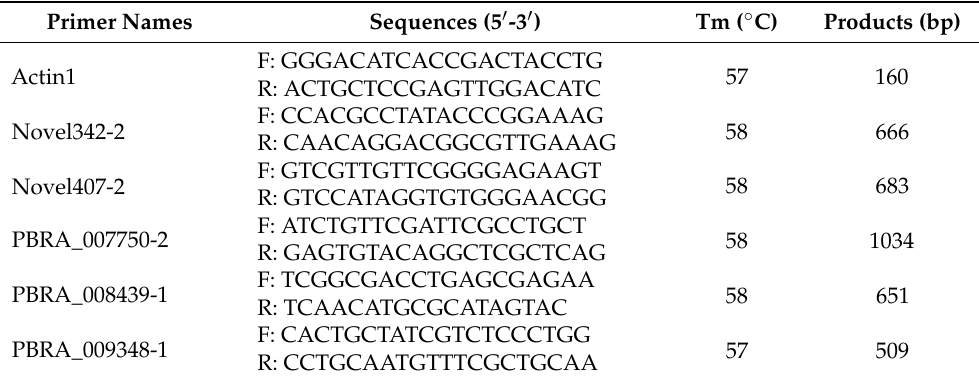
Table 3. The information of clubroot pathogen identification